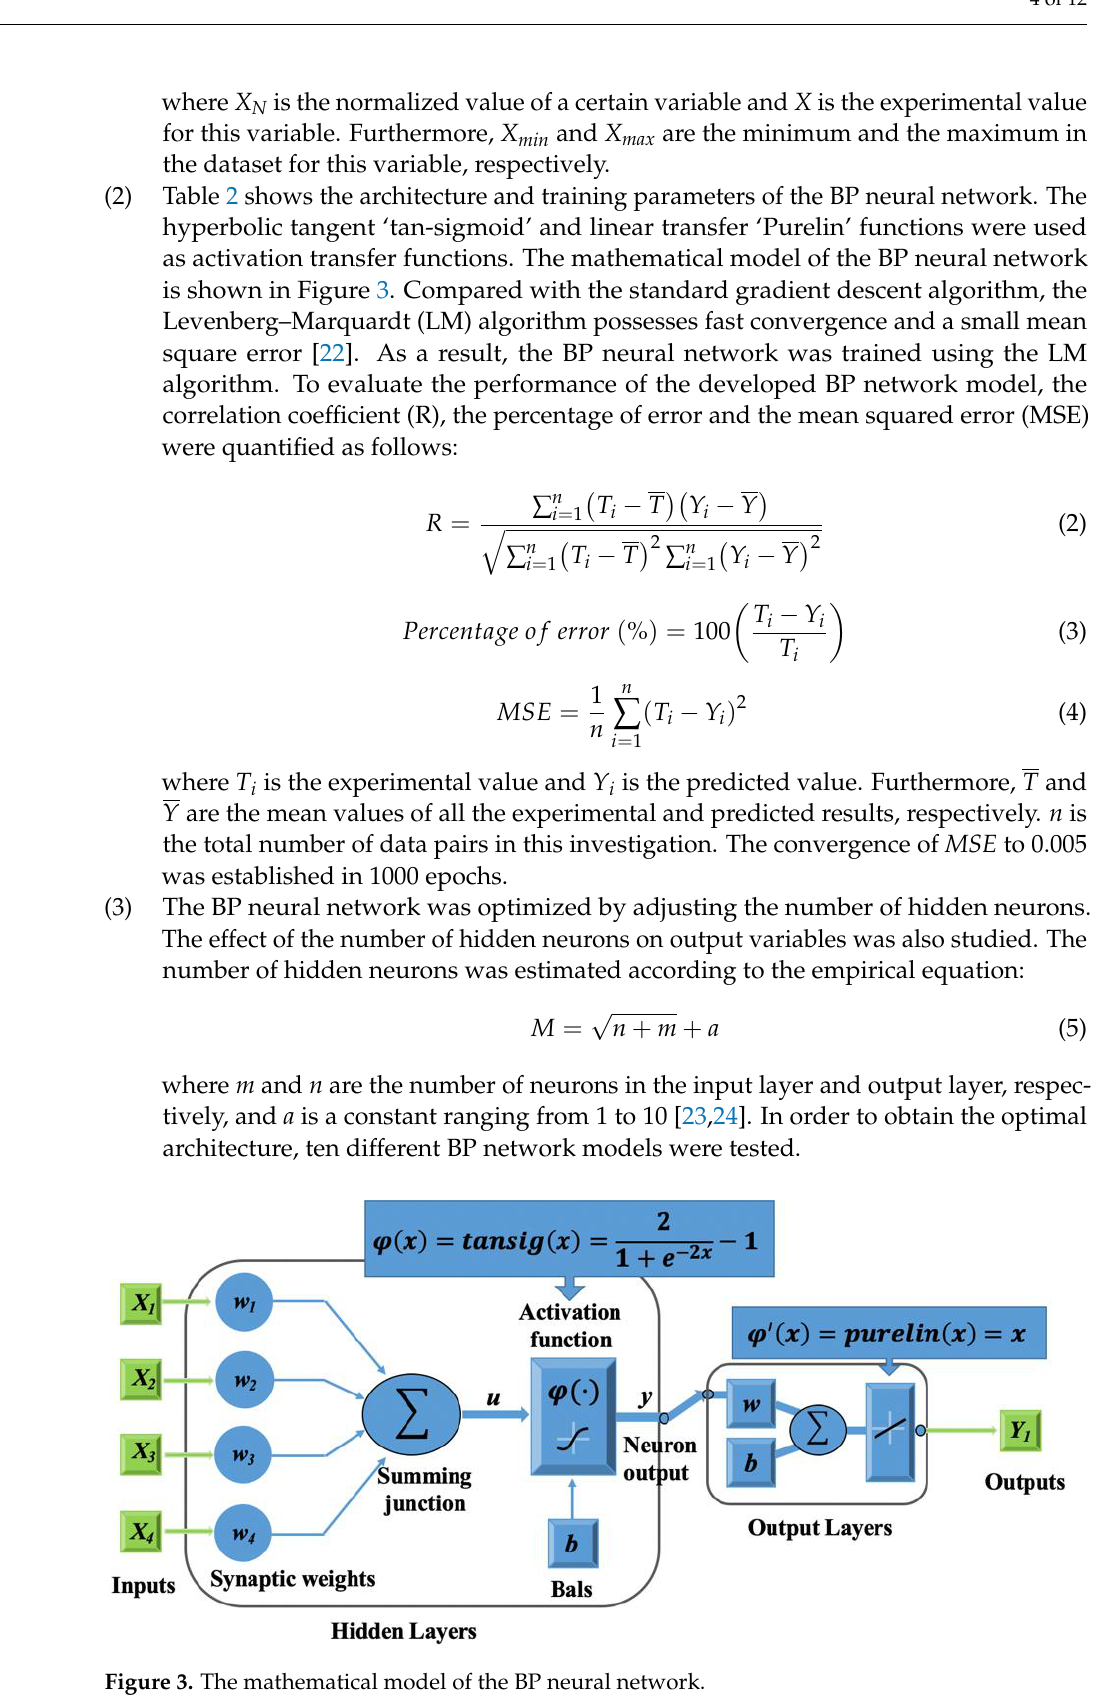
Figure 3. The mathematical model of the BP neural network.